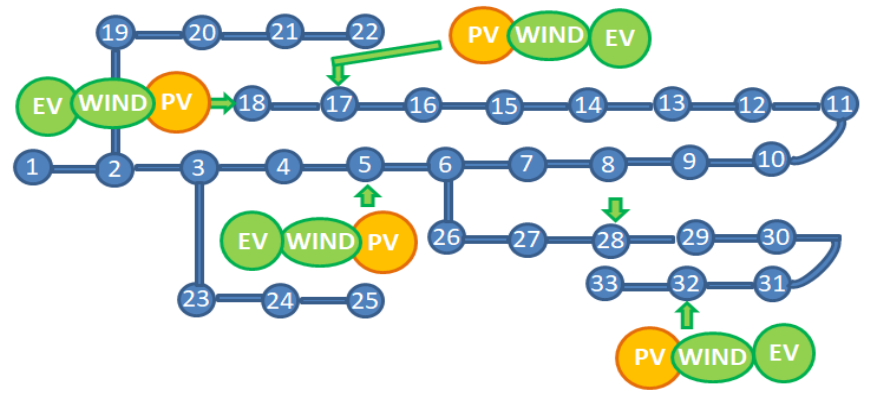
Figure 4. IEEE 33 distribution network structure.